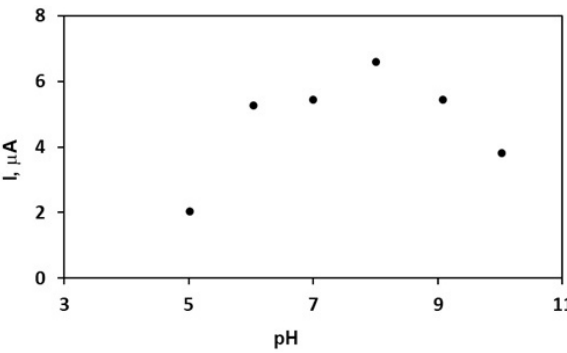
Figure 7. Effect of pH of ziram solutions on the current intensity of AuNPs/RGO/GCE